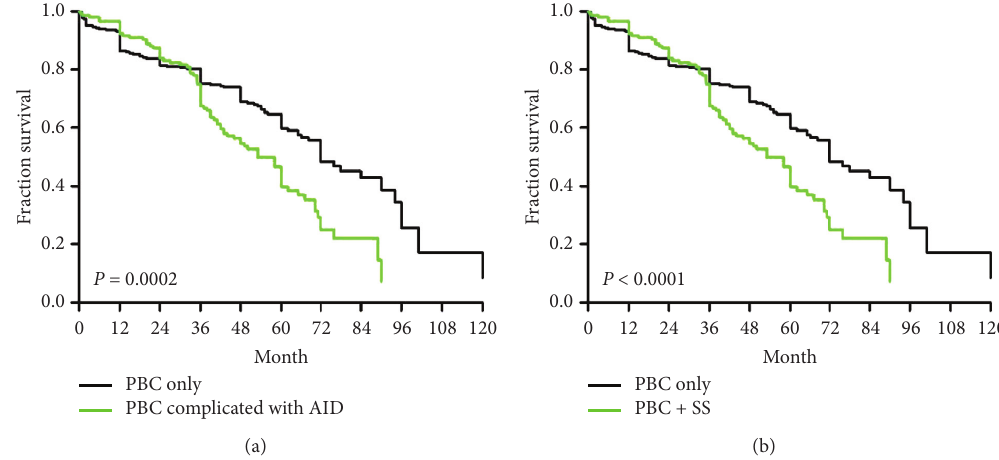
Figure 1: Kaplan–Meier curves for overall survival of patients with primary biliary cholangitis (PBC; black curve, median: 72 months) and those with PBC complicated with autoimmune diseases; green curve, median: 58 months. (a). Kaplan–Meier curves for overall survival of patients with primary biliary cholangitis (PBC; black curve, median: 72 months and those with PBC complicated with Sj¨ogren’s syndrome; green curve, median: 50 months) (b). AID: autoimmune disease; SS: Sj¨ogren’s